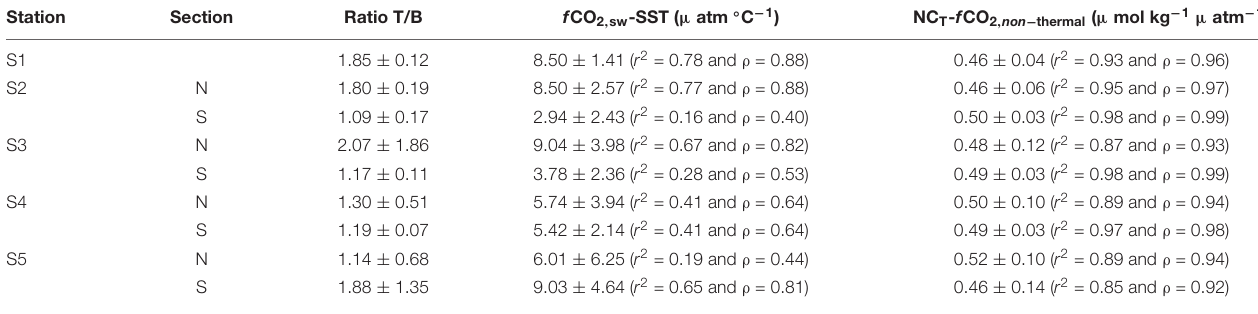
TABLE 2 | Ratios T/B and linear relationship of f CO 2 , sw -SST and NC T - f CO 2 , non − thermal at the northern and southern part of the selected stations along the Strait of Gibraltar.